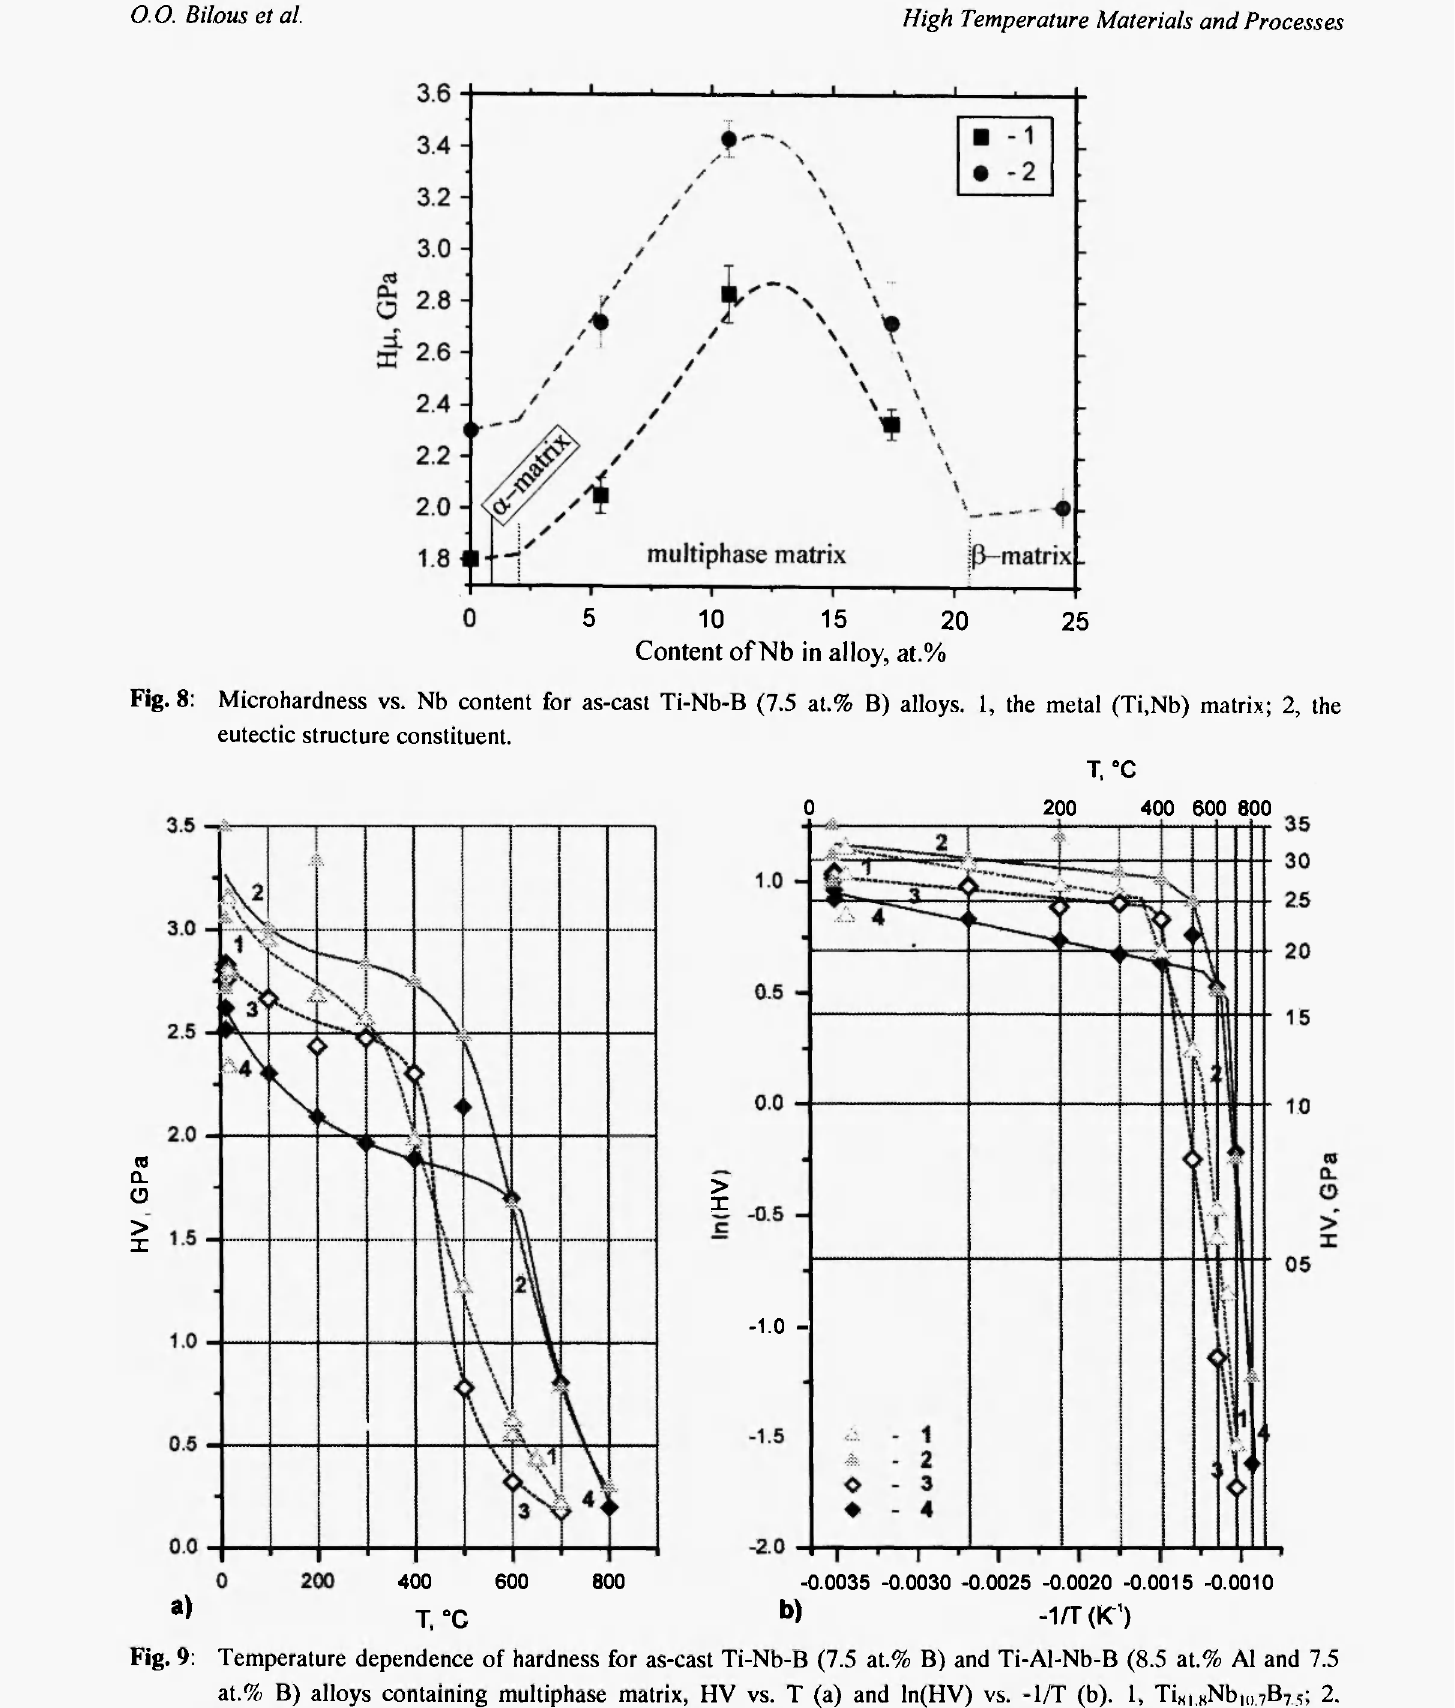
Fig. 9: Temperature dependence of hardness for as-cast Ti-Nb-B (7.5 at.% B) and Ti-Al-Nb-B (8.5 at.% Al and 7.5 at.% B) alloys containing multiphase matrix, HV vs. Τ (a) and ln(HV) vs. -1/T (b). 1, Ti„,. x Nb,„. 7 B 75 ;